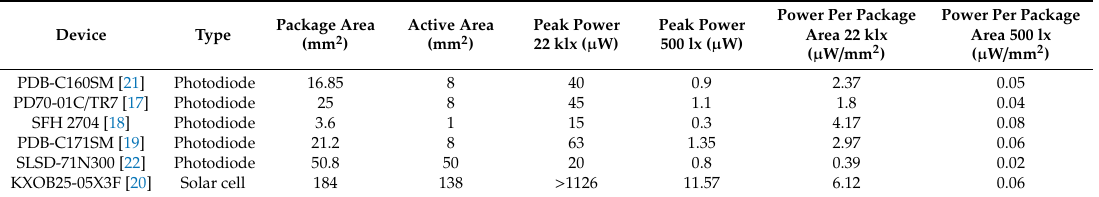
Table 1. Power output comparison of potential devices to power the RFID tag.